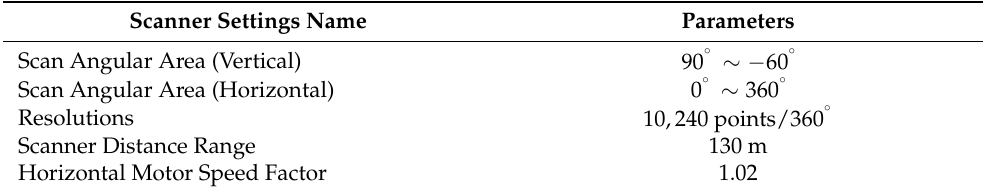
Table 1. Scanner settings